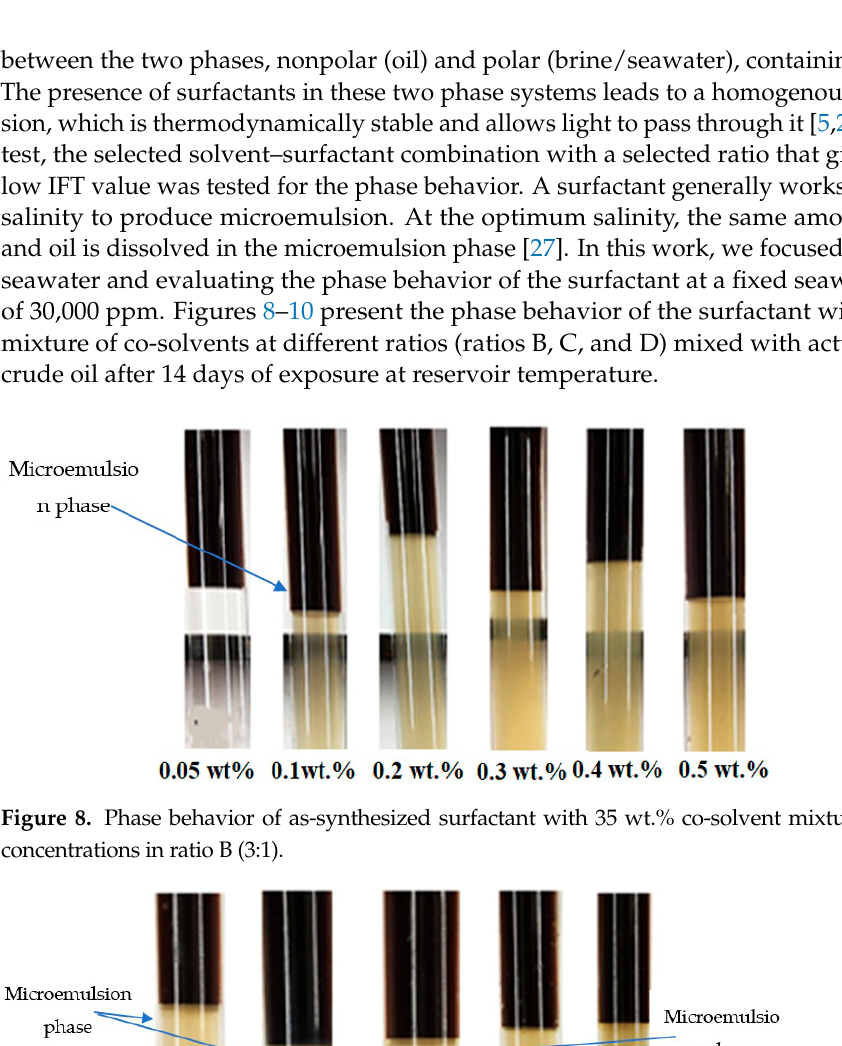
Figure 9. Phase behavior of as-synthesized surfactant with 35 wt.% co-solvent mixture at different concentrations in ratio C (4:1).